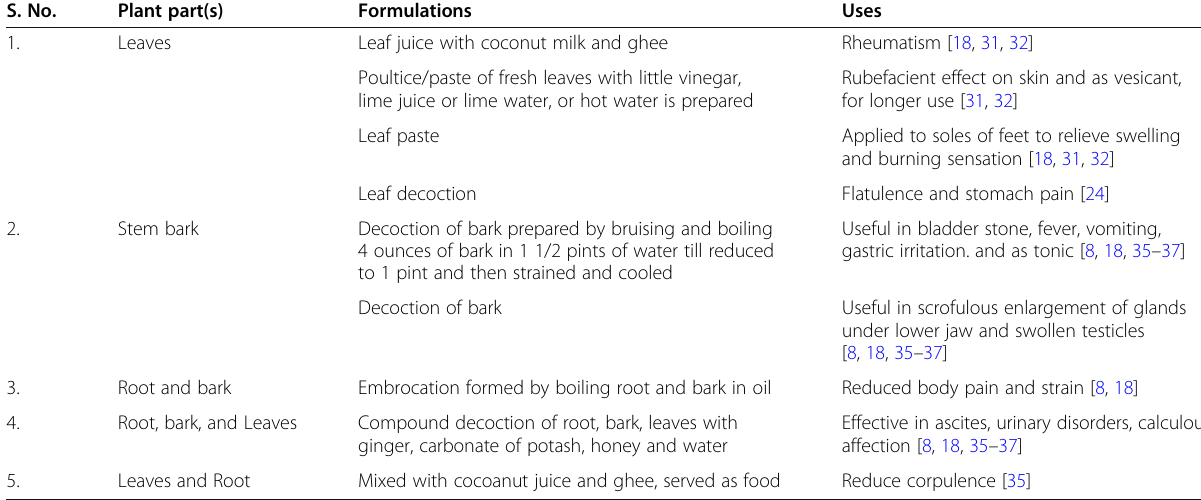
Table 1 Traditional uses of C .